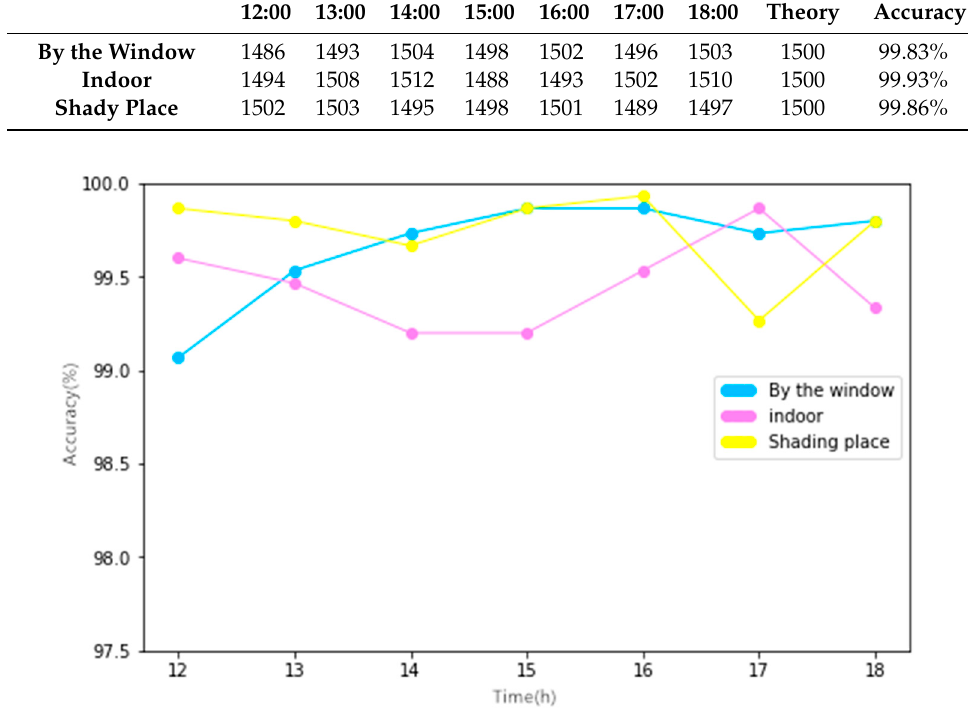
Figure 9. The change in accuracy in this test. Table 1. Test data record.